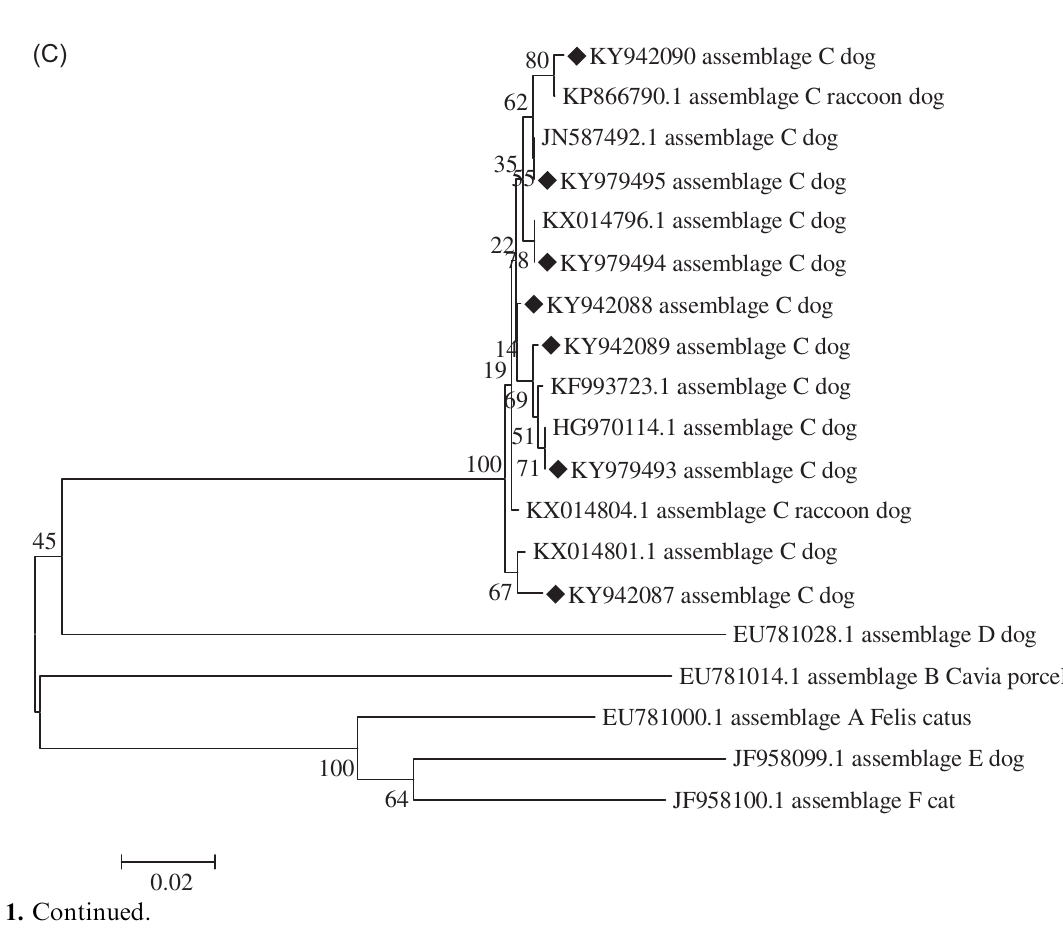
Table 2. Genotypes of Giardia duodenalis isolates from dogs in Chengdu, Yaan, and Leshan in Sichuan province, China at the bg , gdh, and tpi loci.